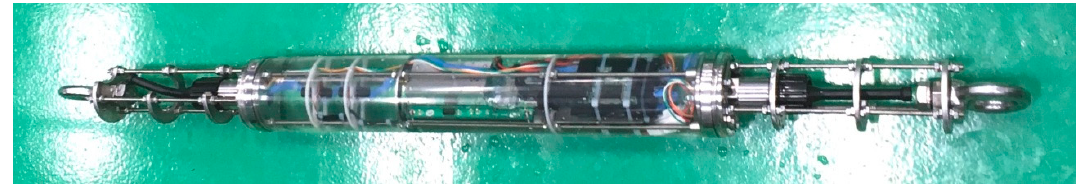
Figure 7. Photograph of an acoustic module without the buoyancy materials.